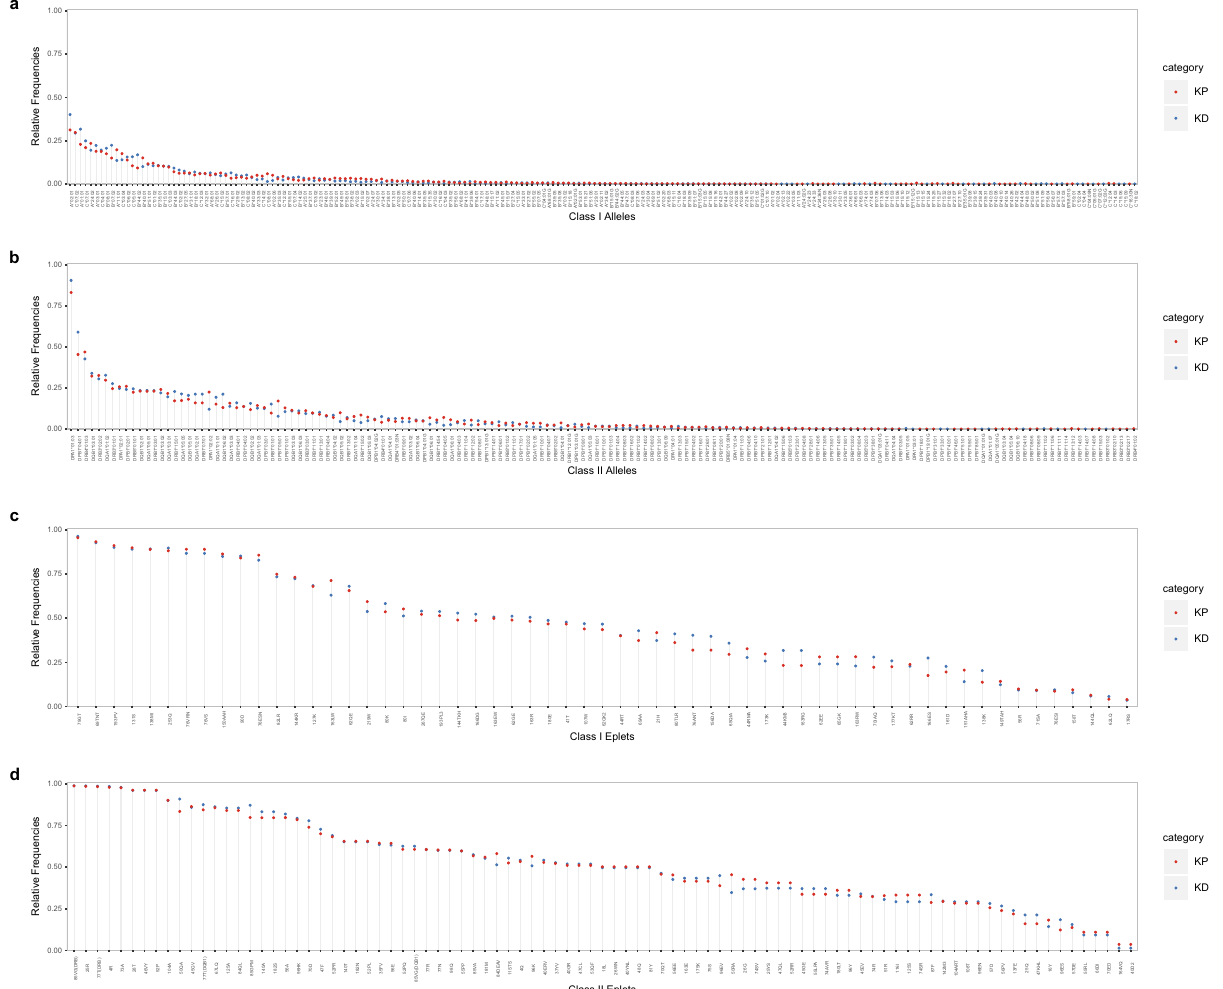
Fig. 4 The relative frequencies of HLA alleles and eplets in the study population. Relative frequencies were calculated as the proportion of subjects expressing a particular allele or eplet within kidney patients ( n = 1049) or donors ( n = 797). a , b Depict the allele frequencies by class I and II, respectively. c , d Depict eplet frequencies by class I and II, respectively. KP kidney patients, KD kidney donors.